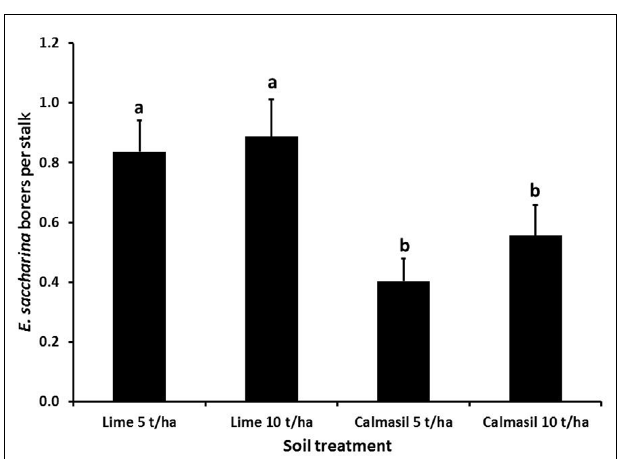
FIGURE 1 | Mean ( ± SE) number of E. saccharina recovered per stalk from sugarcane cultivars (N27 and N33) fertilized at different N rates (N1, N2, and N3) inTrial 1. Bars with the same letter/s above them do not differ significantly (Holm–Sidak test, p < 0.05).